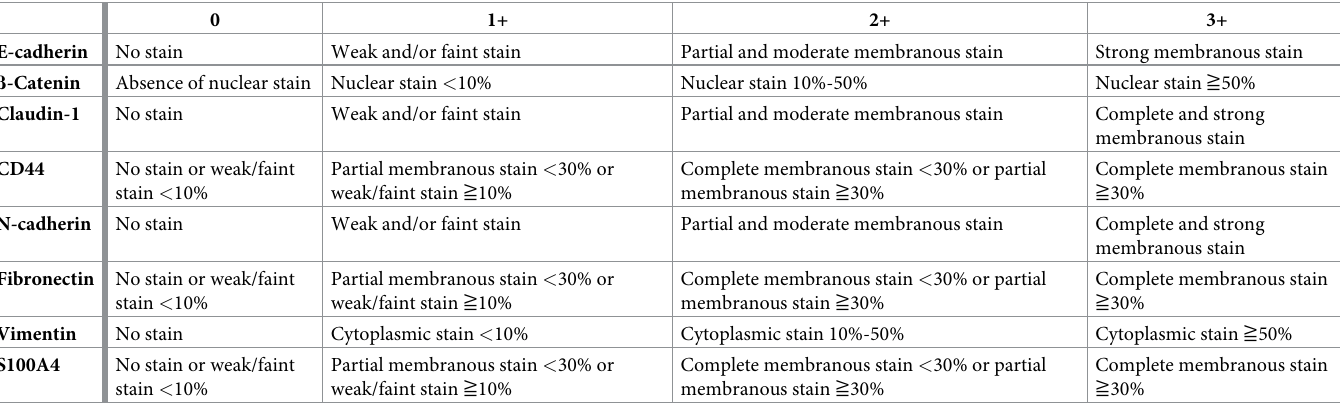
Table 2. The immunohistochemical scoring of the EMT-related